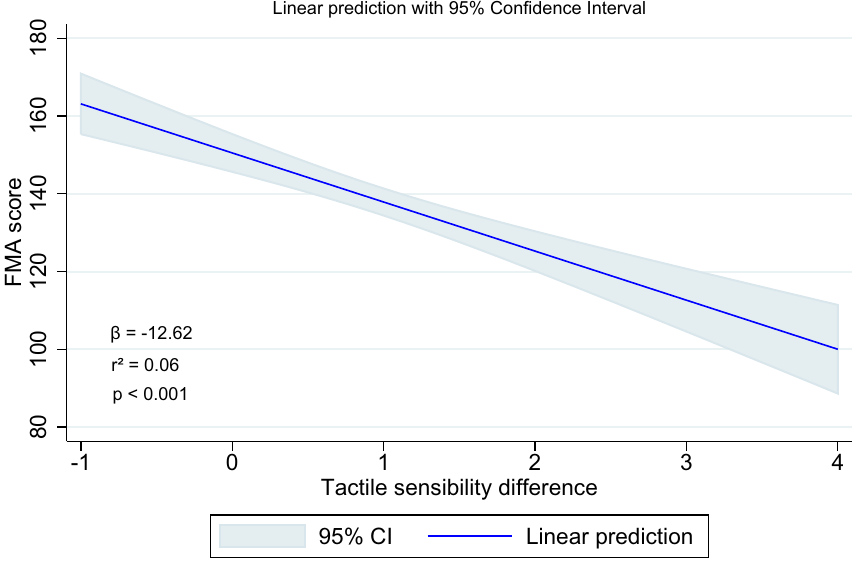
Figure 4. Linear prediction of sensorimotor recovery (FMA) over tactile sensibility difference. Image obtained by the Stata14 program (https:// www. stata. com/ stata 14/).